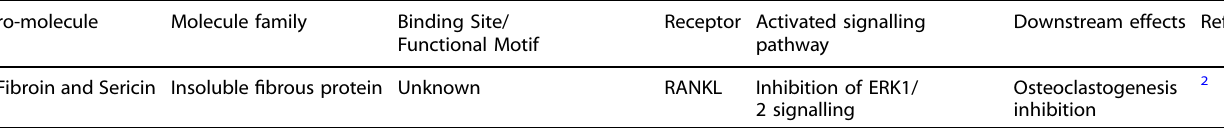
Table 1. Biologically active sequences may be sub-classi fi ed into primary sequence recognition sites (in which a receptor directly bind with a speci fi c amino acid sequence or carbohydrate repeats) and secondary and tertiary structures (which depend on molecular conformation, motifs, and domains for recognition).